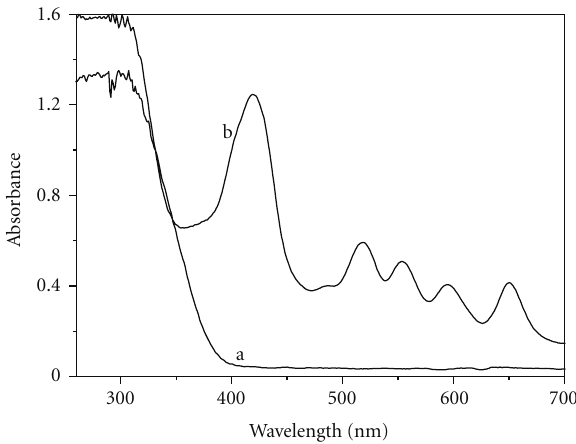
Figure 3: FT-IR spectra of APTMPP-MPS (a), TiO 2 (b), APTMPP- MPS-TiO 2